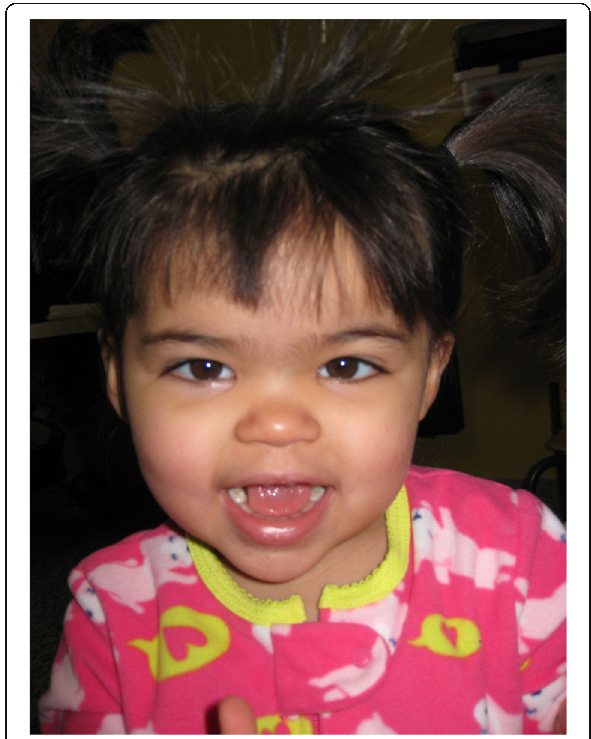
Fig. 2 Facial appearance of patient 1 with SLC35A2